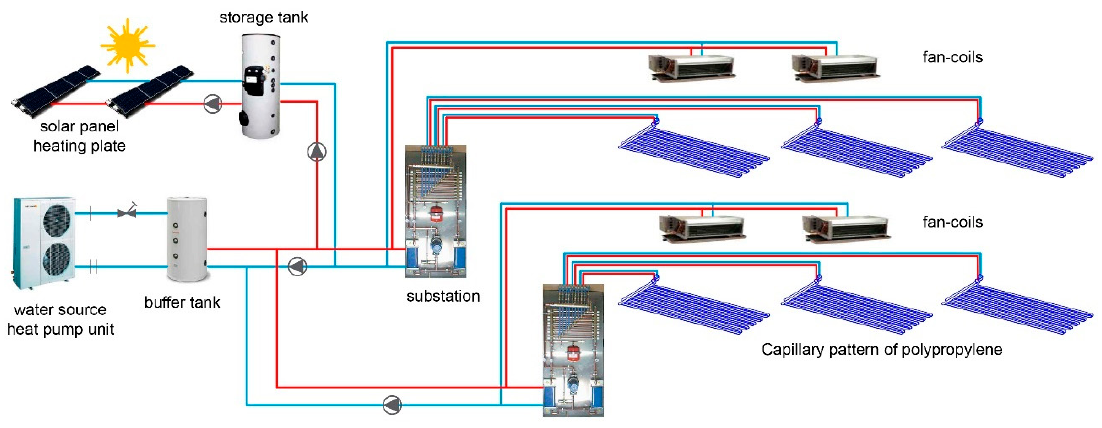
Figure 4. The circuit installation diagram based on two tubes with substations and renewable energies.